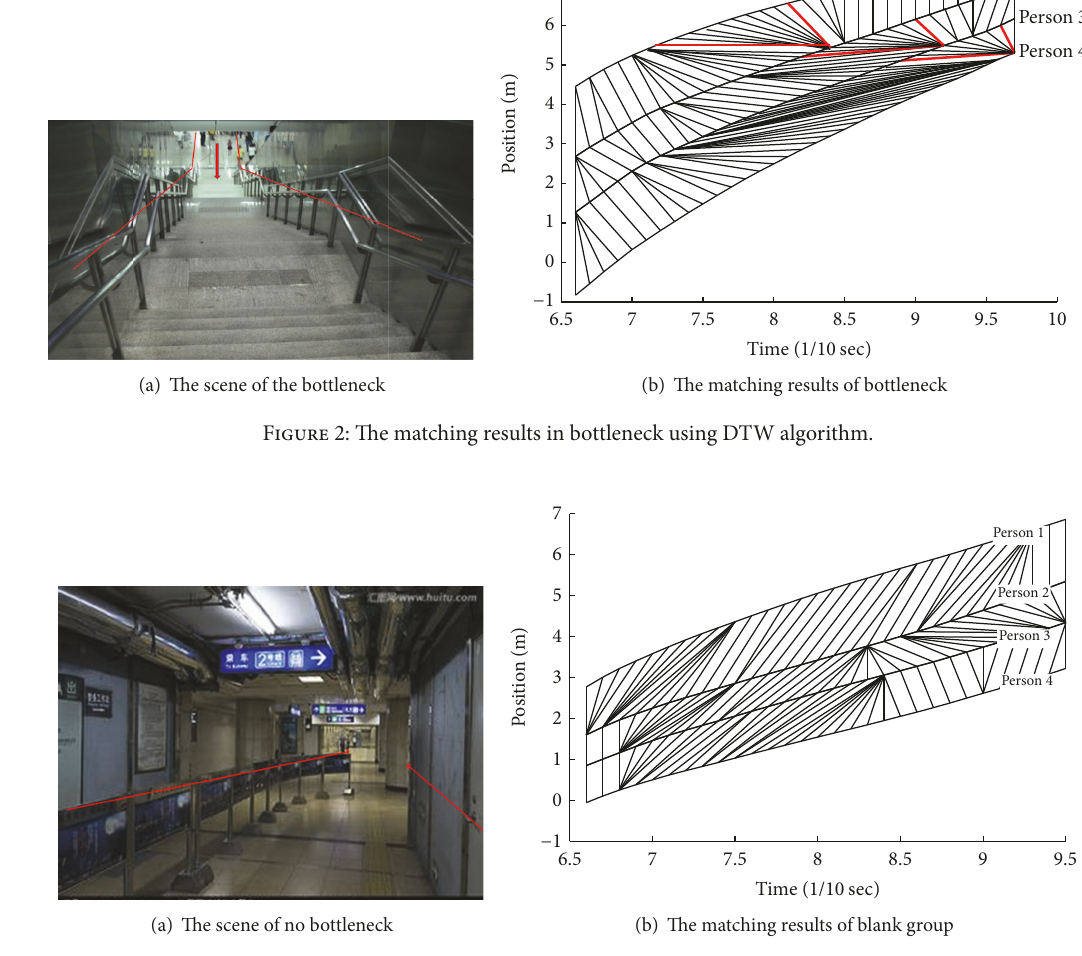
Figure 3: The matching results in channel using DTW